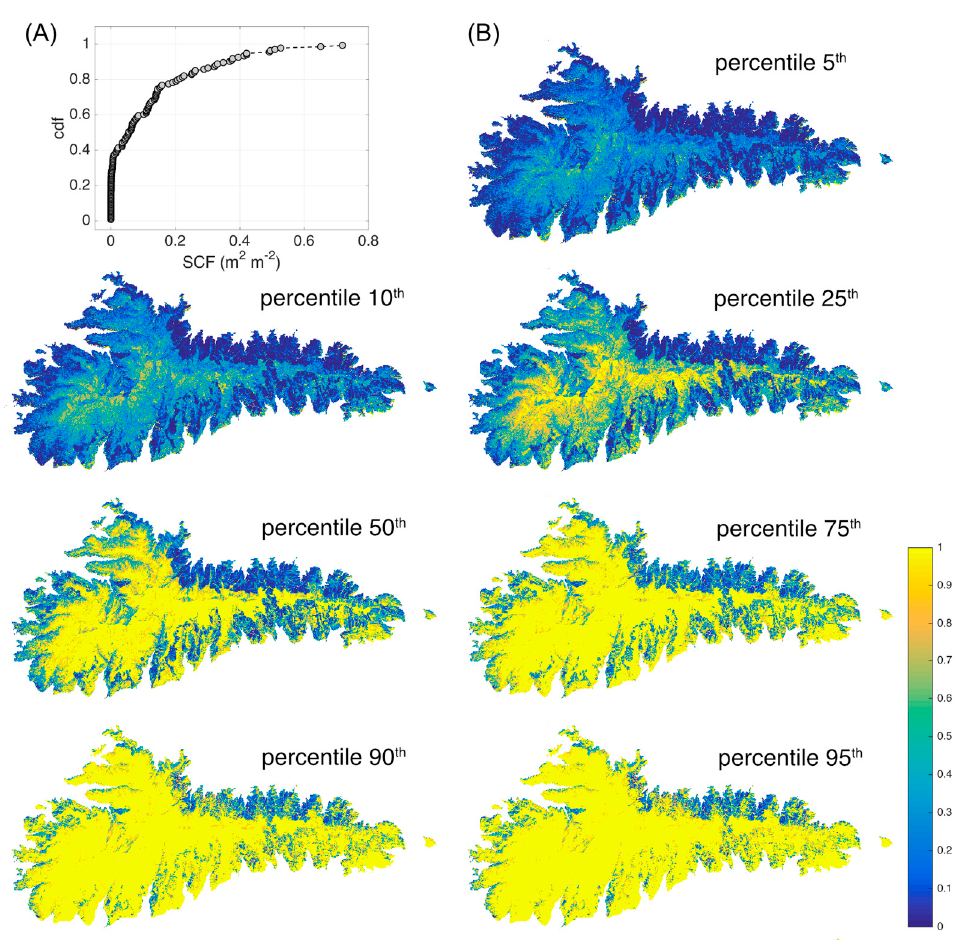
Figure 8. ( A ) Cumulative distribution function (cdf) of the average SCF in the study area for the 2000–2013 period. ( B ) Spatial distribution of selected percentiles (5th, 10th, 25th, 50th, 75th, 90th and 95th) of the pixel-SCF cdfs.